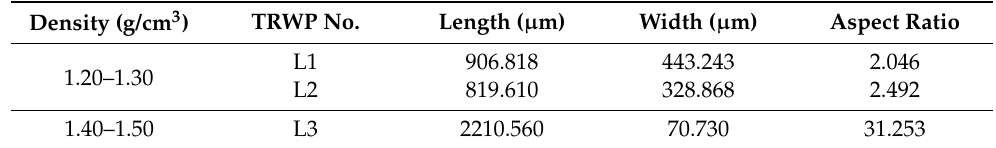
Table 2. Aspect ratios of TRWPs separated from the RD2 sample (212–500 µ m). Density (g/cm 3 ) TRWP